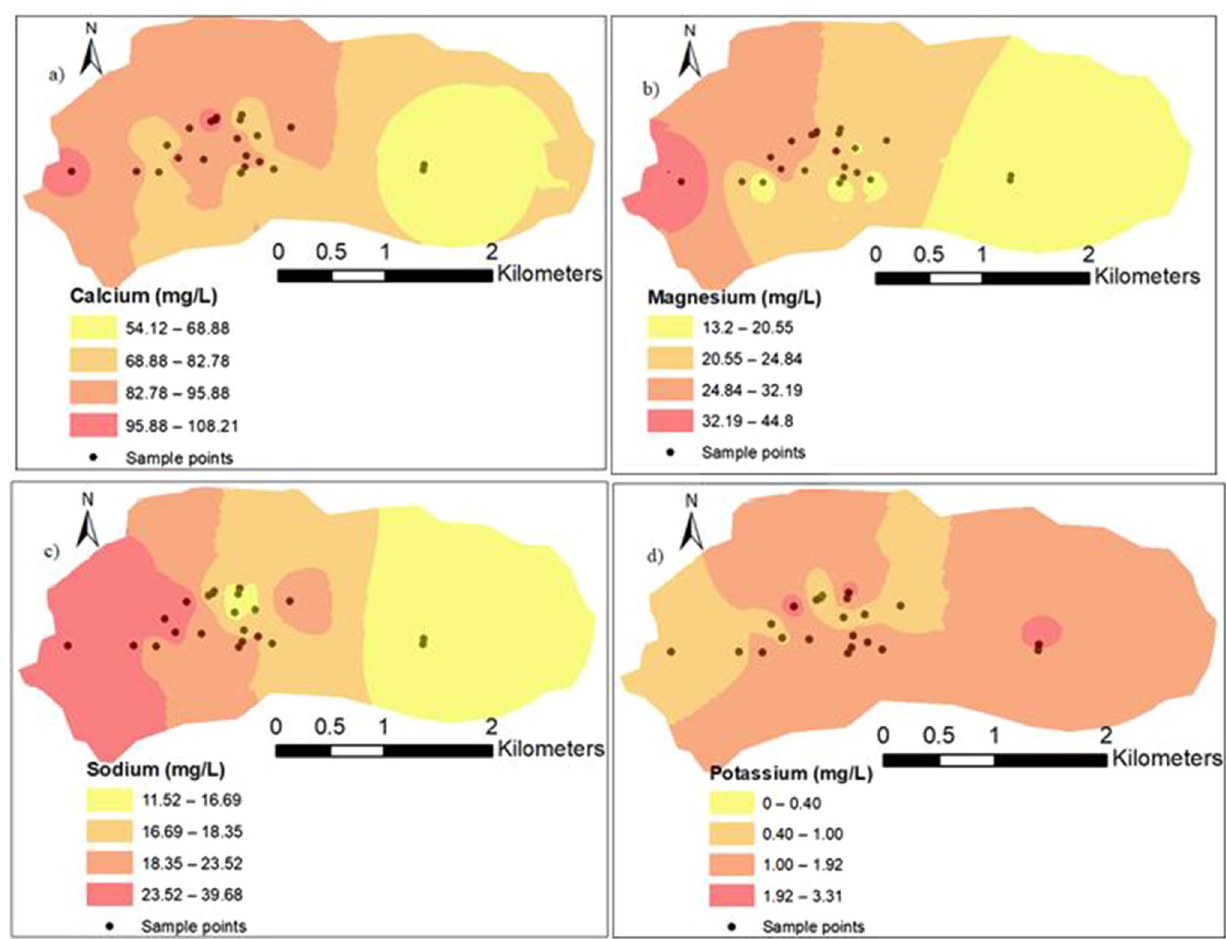
Fig. 3 Spatial distribution for major cations classification based on weighted overlay